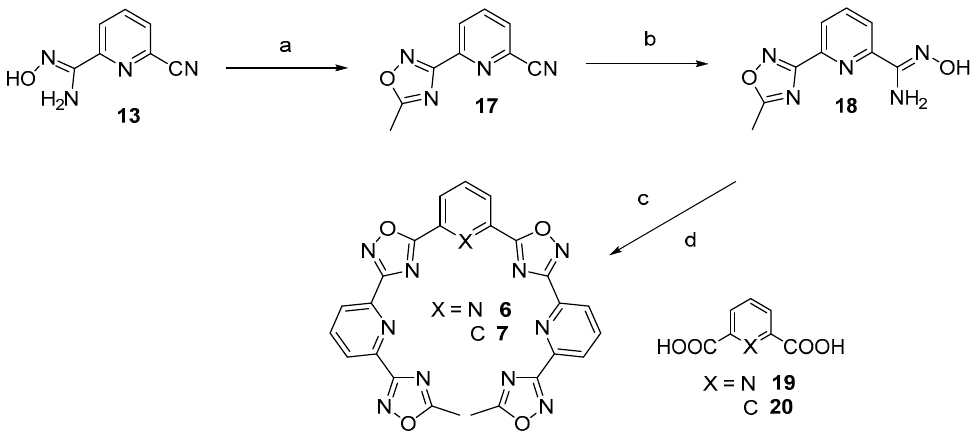
Scheme 2. Multi-step synthetic protocol developed for the preparation of the heptaheterocyclic compounds TOxAzaPy and TOxAzaPhen ( 6 and 7 ): ( a ) acetic anhydride, CHCl 3 , 16 h, r.t.;